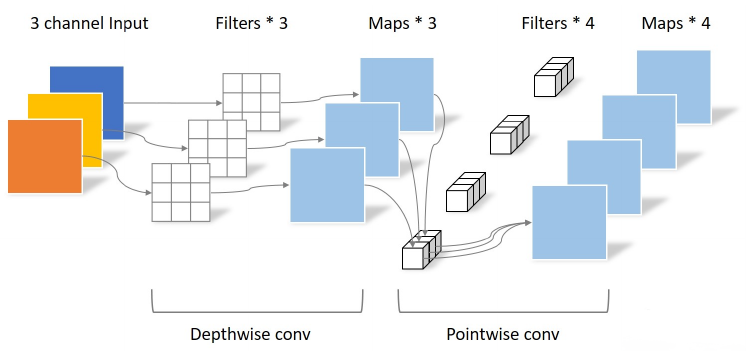
Figure 2. Depthwise Separable Convolution process